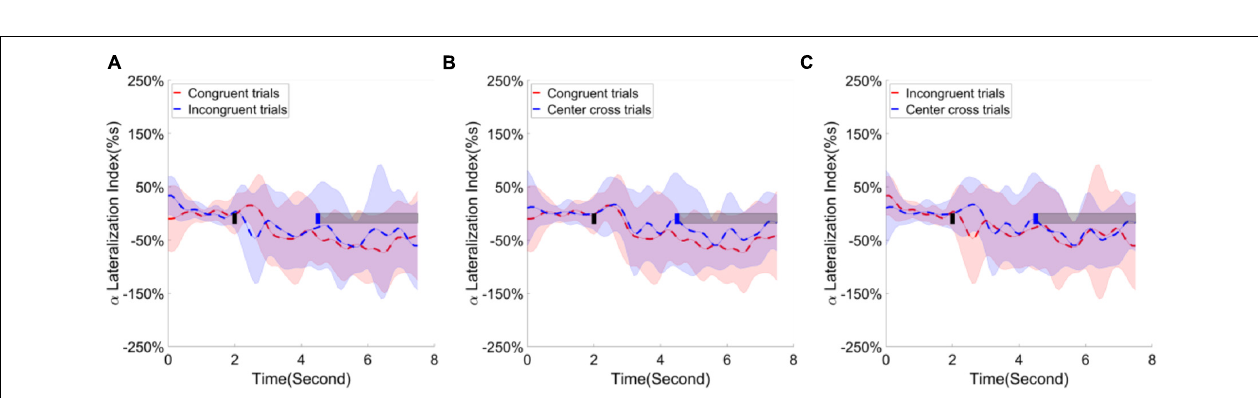
FIGURE 9 | Group average alpha ERD/ERS task difference across the time in the frontal area. Shaded areas represented the stand error of an alpha ERD/ERS task difference. The target cue appeared at the end of second 2, which was indicated by a short black bar. The cursor feedback began at the second of 4.5, which was marked by a short blue bar. The light gray bar represented the feedback period. The dark gray bar demonstrated the period of significant difference. Contrast analysis of alpha ERD/ERS task difference process in the frontal area between (A) congruent trials and incongruent trials, (B) between congruent trial and center cross trials, (C) between incongruent trials and center cross trials.